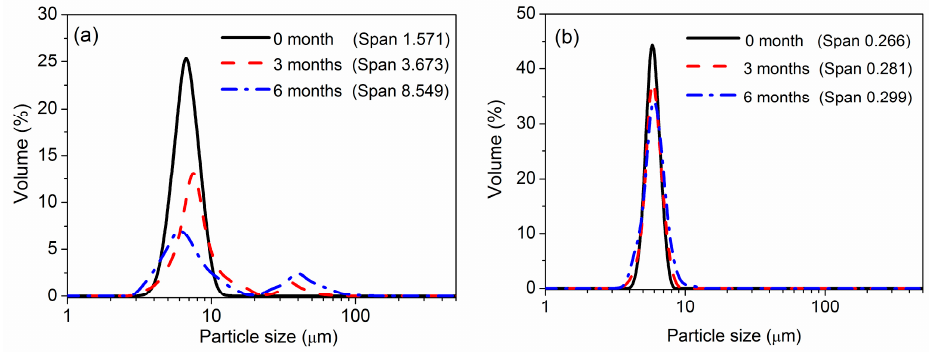
Figure 12. Size distribution of the PNIPAM ( a ) and semi-IPN3 ( b ) microspheres at different storage times (4 °C, 10 mM pH 7.0 PBS solution).